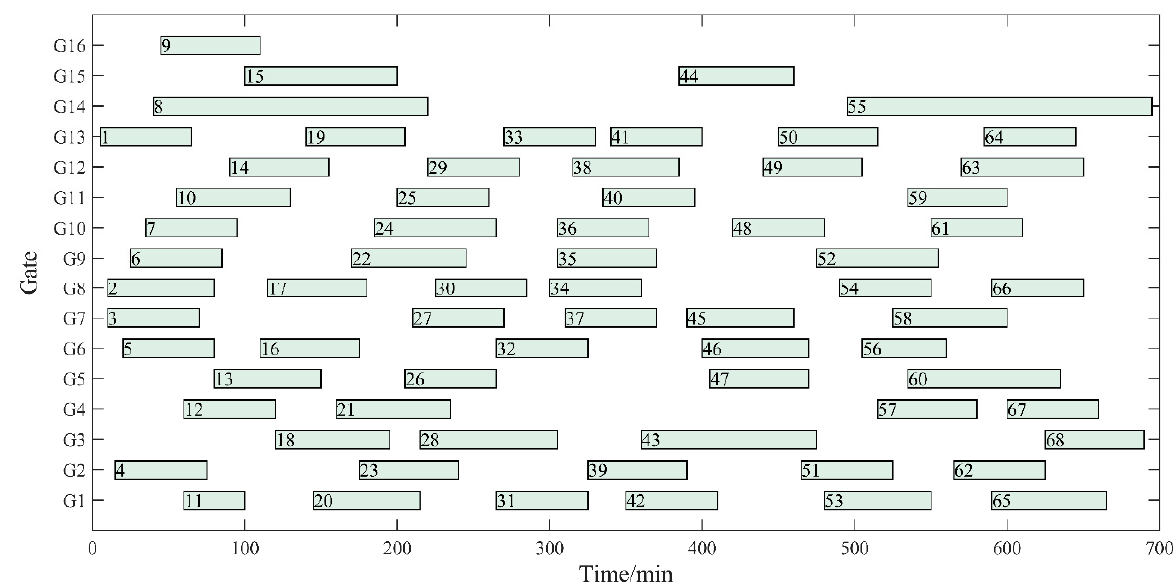
Figure 6. Gantt chart of the NSGA-II algorithm gate assignment solution.